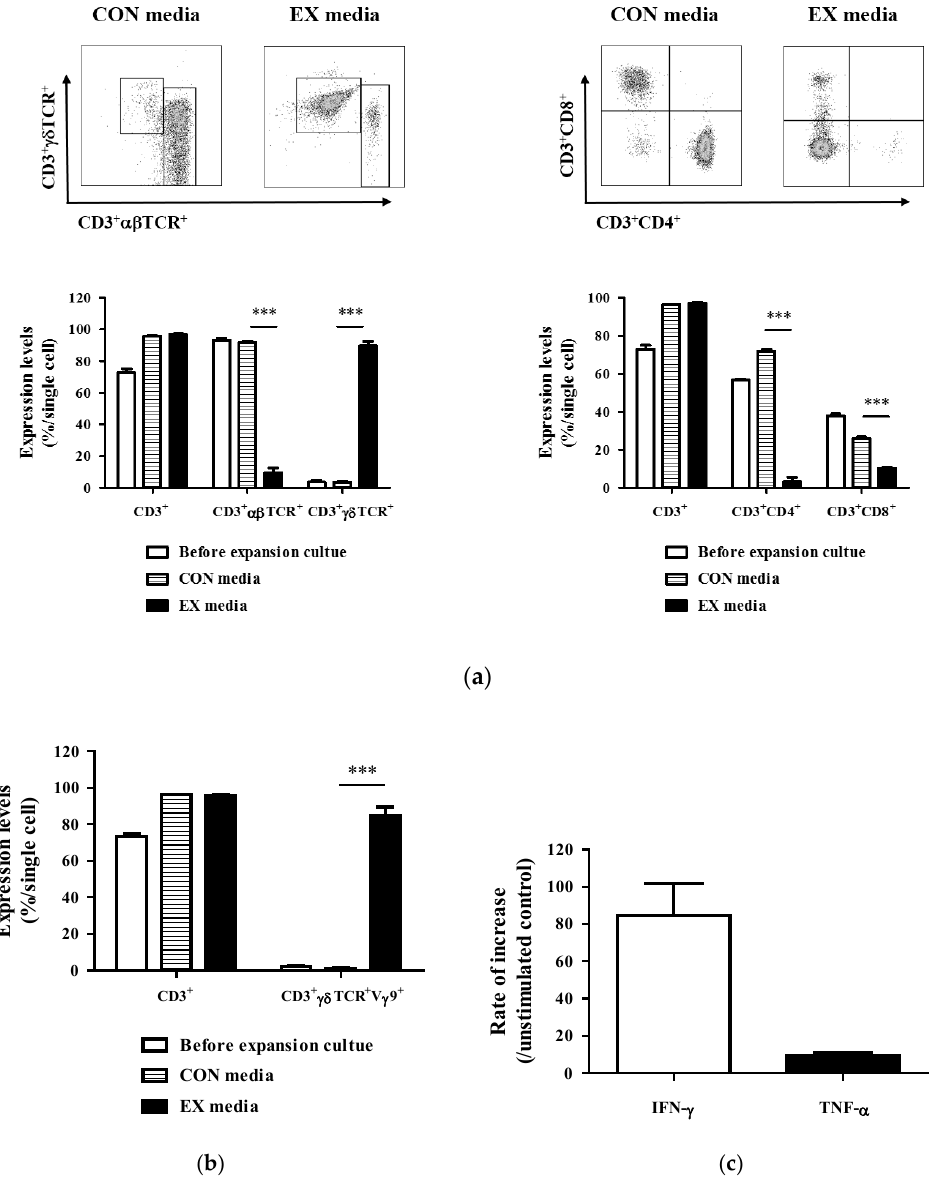
Figure 2. Activation and cytokine production by expanded γδ T cells. γδ T cell-derived peripheral blood mononuclear cells (PBMCs) were cultured under optimum culture conditions. ( a , b ) Flow cytometric analysis of changes in activation marker expression. After expansion, single cells were stained and analyzed using the BD FACSVerse System. ( c ) ELISA for cytokine production. After expansion culture, the supernatant concentrations of both IFN- γ and TNF- α were measured using an ELISA kit. The percentages are represented as the mean ± SEM, and statistical significance was determined by comparison with the CON media group (*** p < 0.001).